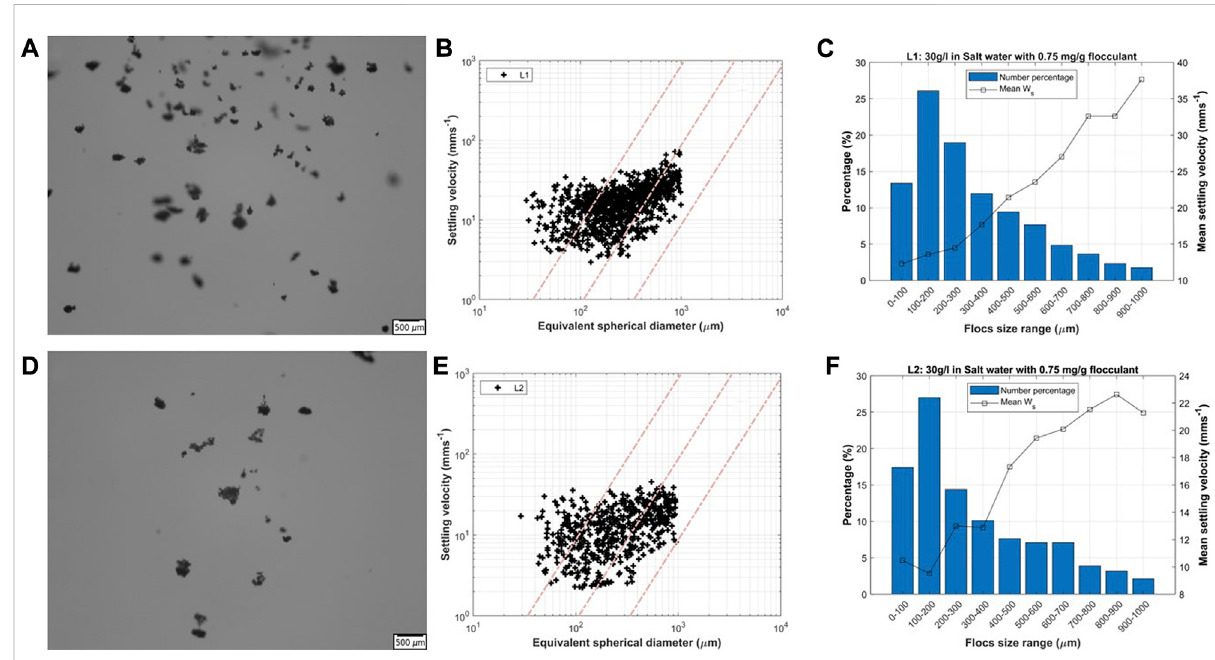
FIGURE 11 Figures (A,D) snapshots of the videos; Figures (B,E) : Settling velocity and particle size analysis of the samples collected at location L1 and L2 during lock exchange experiments with 30 g L − 1 ACCZ and 0.75 mg g − 1 of fl occulant in saltwater (Ali et al., 2022). Settling velocity is derived as a function of equivalent spherical diameter, with diagonal dashed lines representing the contours of effective density calculated by using Stokes equation (from left to right: 1600, 160, 16 (kgm − 3 )). Figures (C,F) show fl oc size range and mean settling